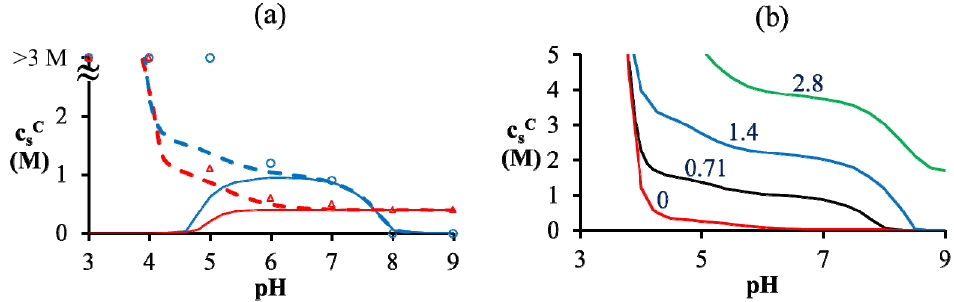
Figure 4. ( a ) Critical KCl concentration against pH for mixtures of PAA with 597 PDMAEMA (blue) and of PAA with PDADMAC (red) for (cid:1864) = 0.71 nm. Symbols 526 597 557 (cid:3003) represent experimental data with error bars roughly the size of symbols. Symbols